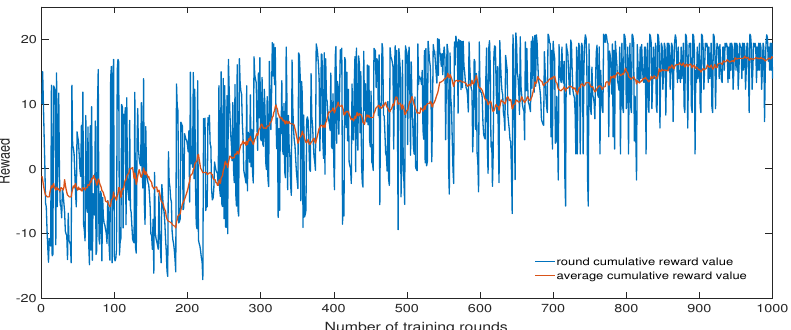
Figure 12. Variation curve of cumulative reward values and average cumulative reward values in rounds.